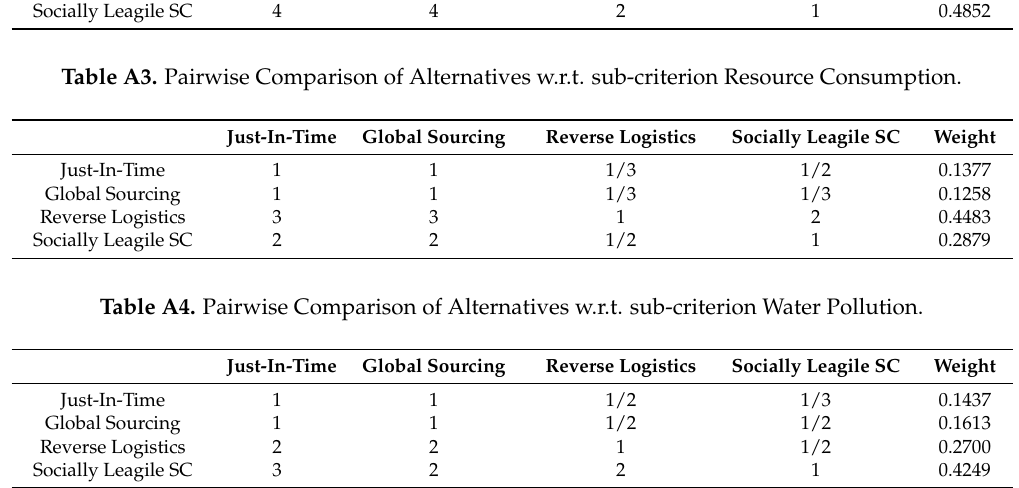
Table A5. Pairwise Comparison of Alternatives w.r.t. sub-criterion Waste Minimization.